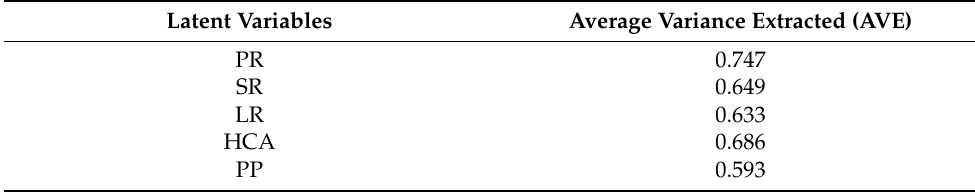
Table 6. Average variance extracted (AVE) of the